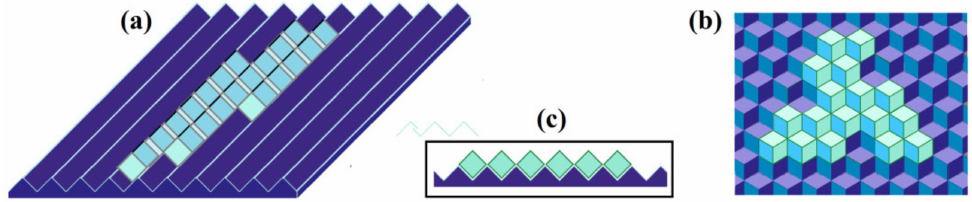
Figure 3. A scheme of the arising ice layers (light blue) on a corrugated ( a ) or fluted ( b ) ice-binding surface (blue–violet). The cross-section ( c ) illustrates the weakness of molecular contacts within the layers covering such surfaces. Due to this weakness, the additional border free energy at the perimeter of the arising ice layers is low; therefore, these new layers are not as compact as that in Figure